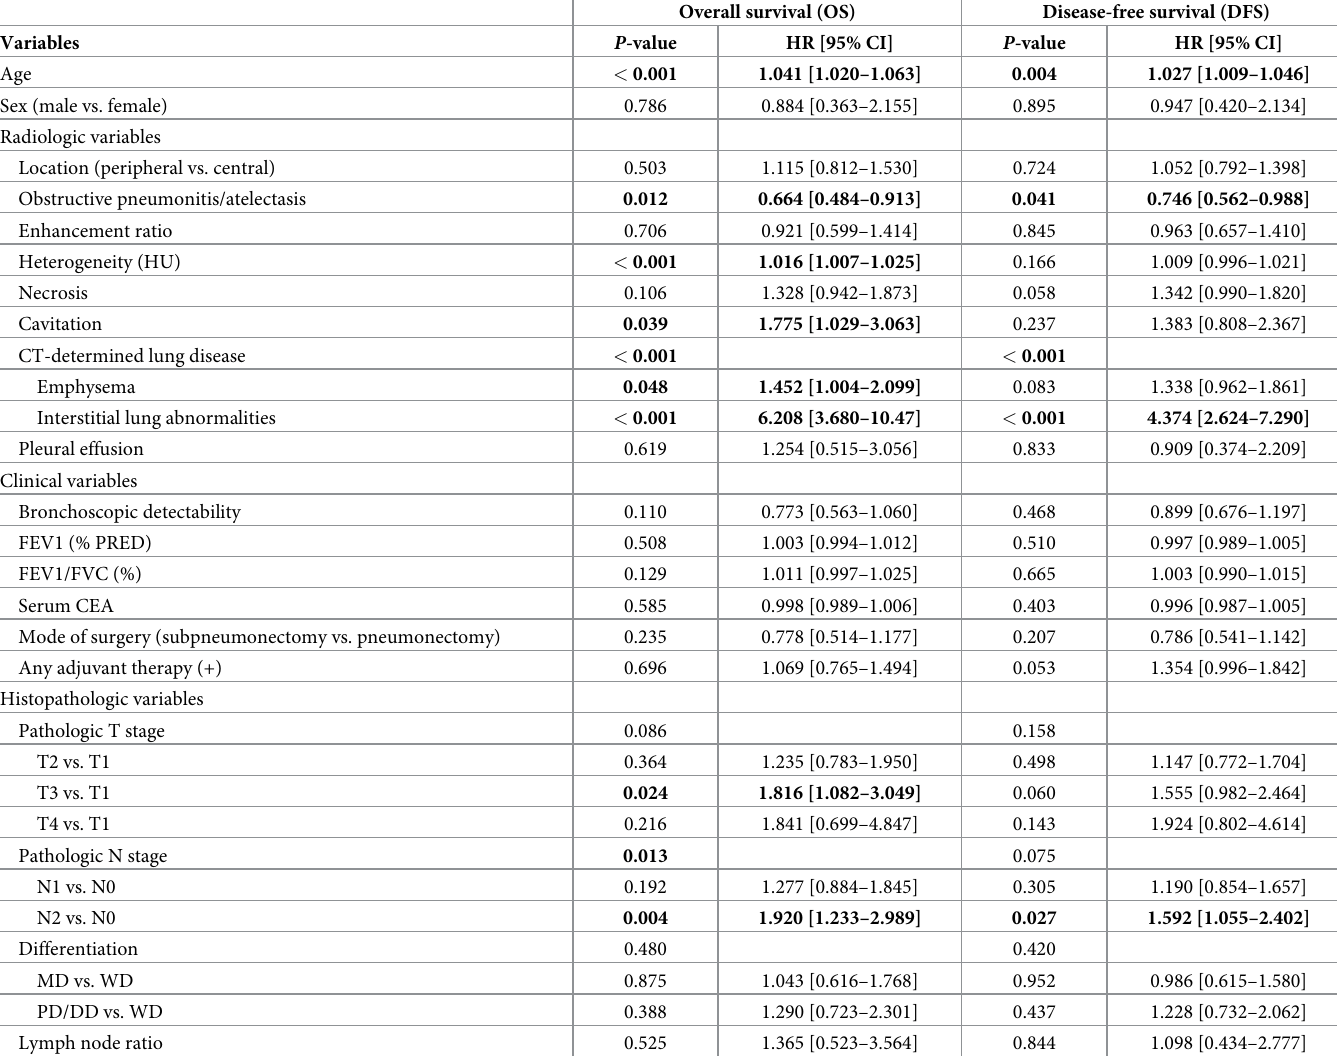
Table 2. Univariate Cox regression analysis between variables and overall survival and disease-free